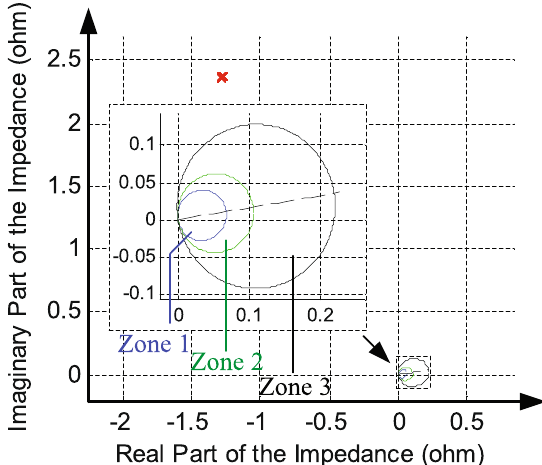
Fig. 9 Calculated impedance trace of event 2: internal high impedance fault, grid-connected mode